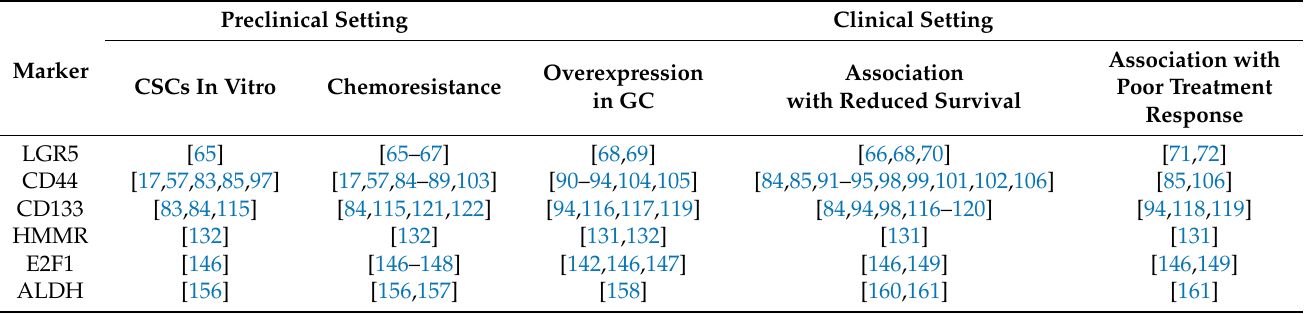
Table 1. gCSC regulators that have been associated with therapy resistance in